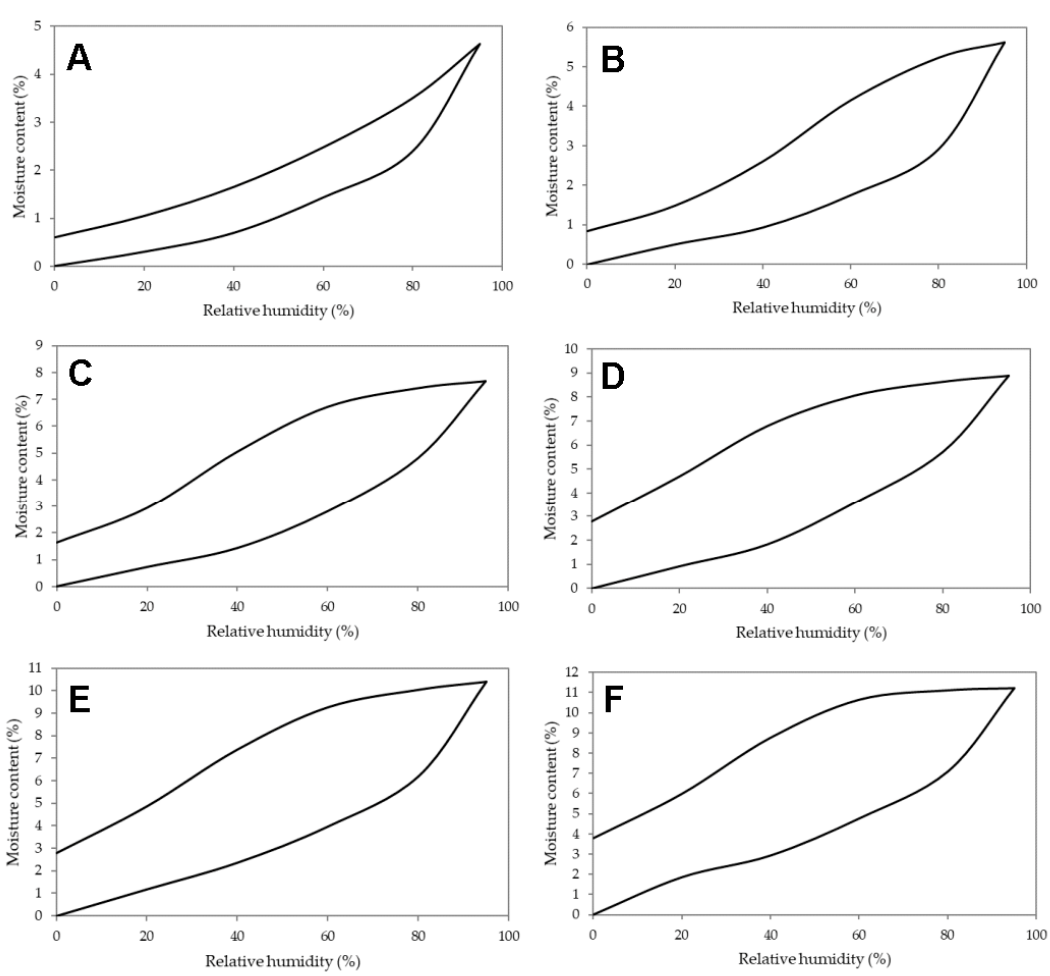
Figure 6. Sorption and desorption isotherms: ( A ) RP; ( B ) PSC1; ( C ) PSC2; ( D ) PSC3; ( E ) PSC4; ( F ) PSC5.